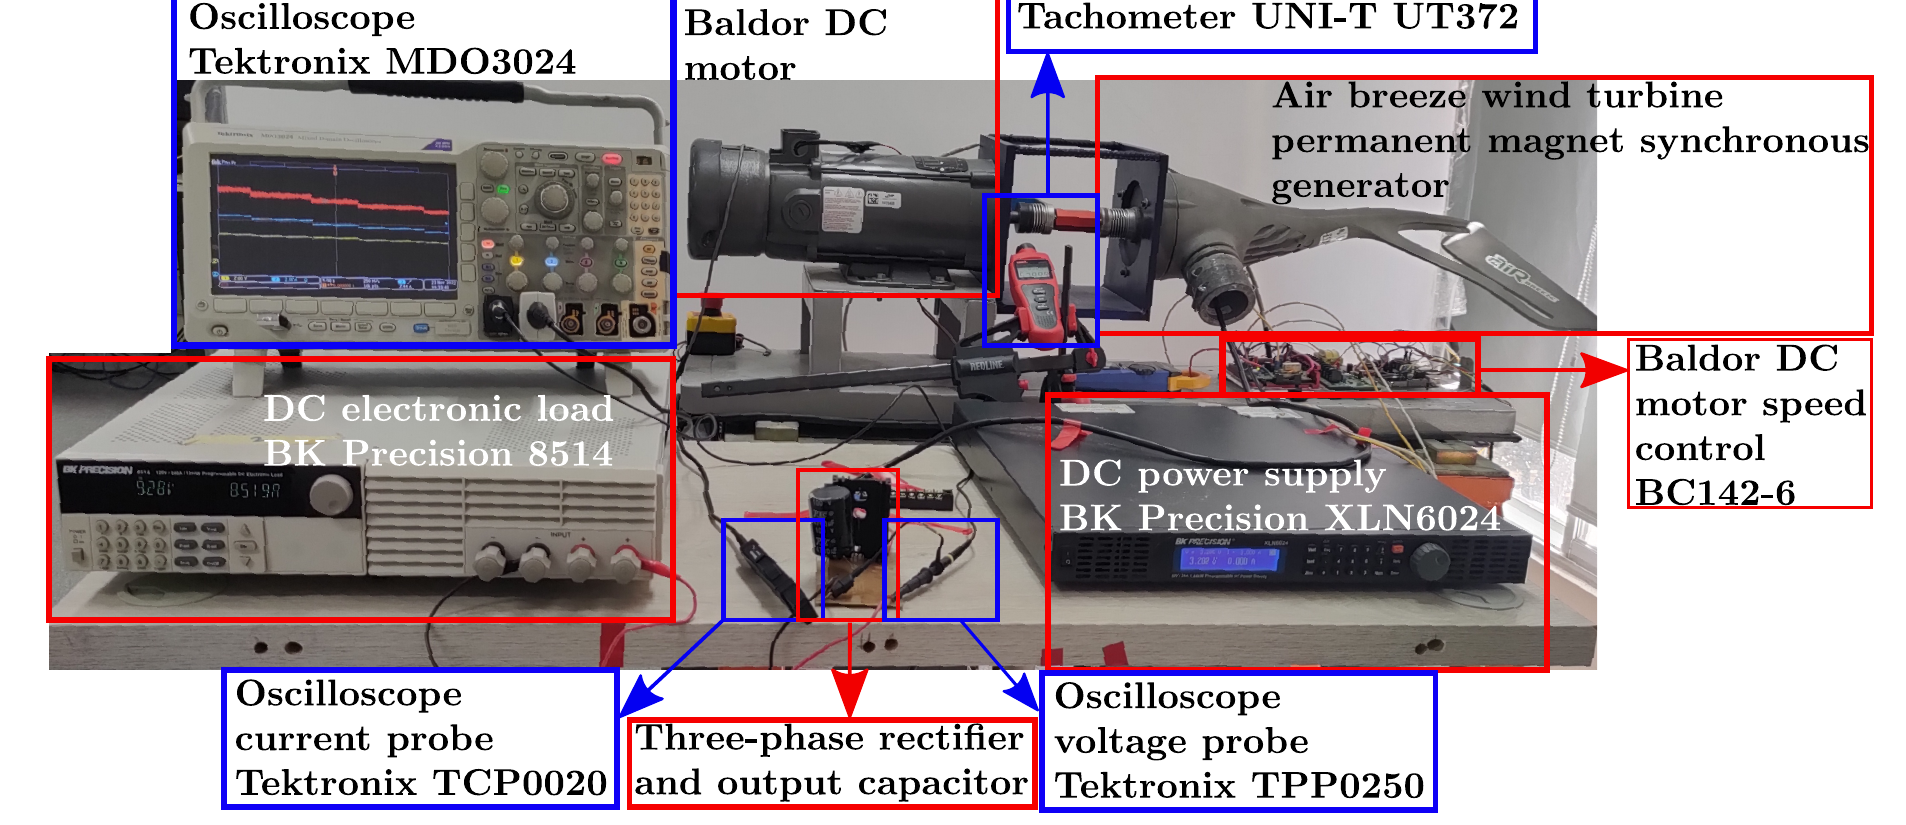
Figure A1. Experimental platform for generation system